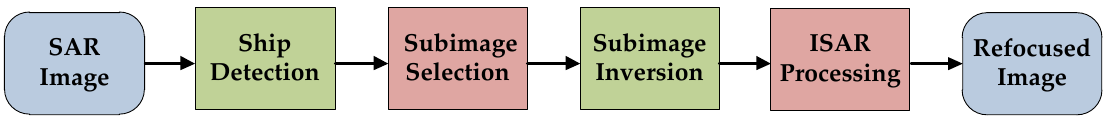
Figure 1. Block scheme of defocused target refocusing in SAR image.